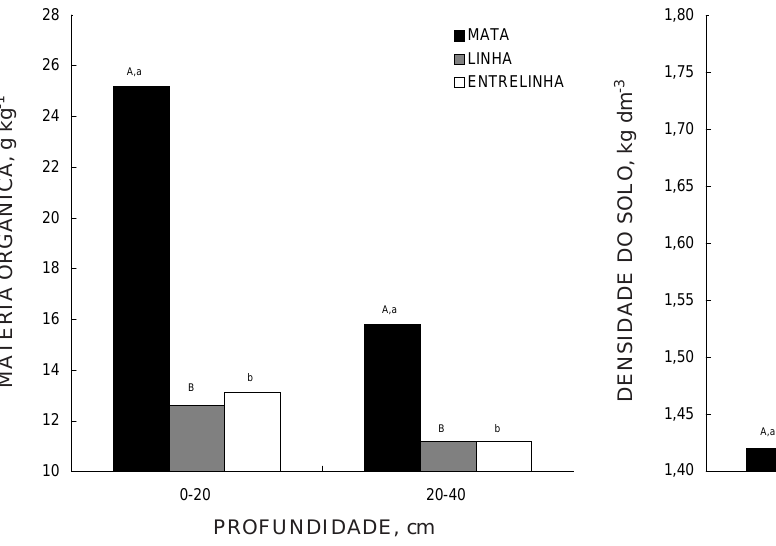
Figura 6. Valores médios de densidade do solo, nas profundidades de 0-20 e 20-40 cm, para os três locais estudados. As letras maiúsculas comparam as áreas sob mata e linha da cultura, a 5% pelo teste t. As letras minúsculas comparam a mata e a entrelinha da cultura, a 5% pelo teste